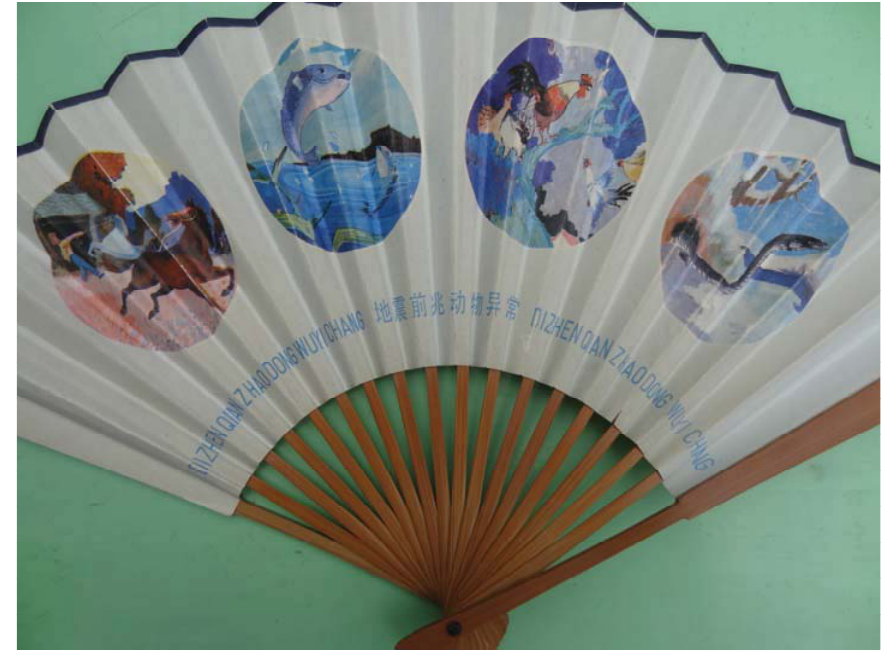
Figure 4. Fan, depicting animal behaviour before earthquakes, with information on how to react (backside), distributed to country people in China in support of a collective earthquake